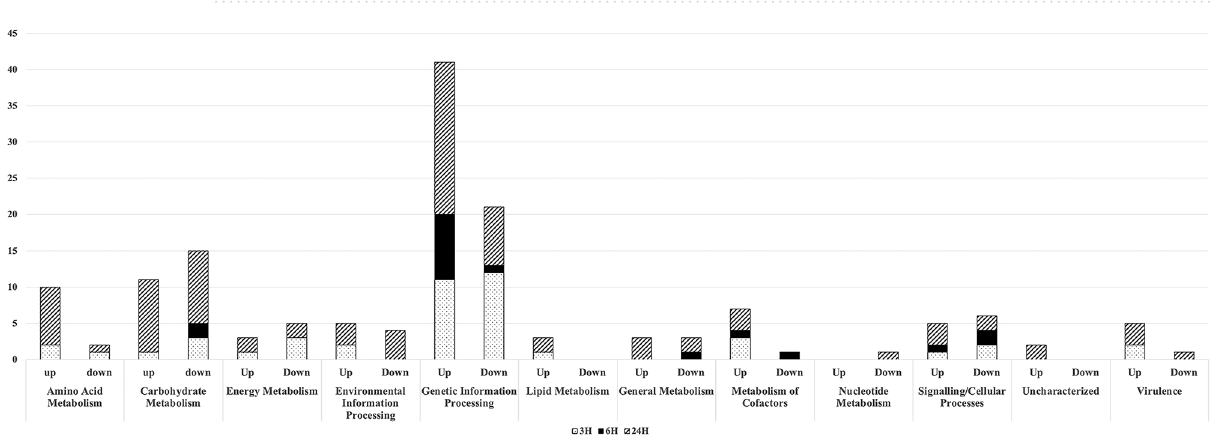
Figure 5. Number of genes significantly modulated in mycolactone treatments compared to controls according to functional category and